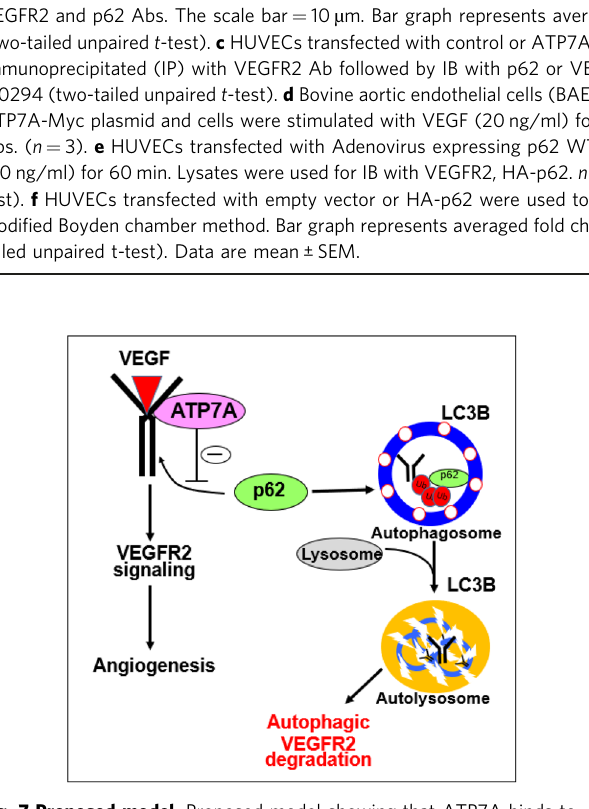
Fig. 6 ATP7A protects against VEGFR2 degradation by preventing VEGFR2 ubiquitination and its binding with p62. a Human umbilical vein endothelial cells (HUVECs) transfected with control or ATP7A siRNAs were stimulated with vascular endothelial growth factor (VEGF) (20 ng/ml) for 30 min in the presence of N-ethylmaleimide (5 mM). Lysates were IP with VEGFR2 followed by immunoblotting (IB) with anti Ubiquitin antibody (Ab) to detect VEGFR2 ubiquitination. The bar graph represents averaged fold change over the control. n = 3, ** p = 0.0031, # p = 0.0002, ** p = 0.0023 (two-tailed unpaired t - test). b HUVECs transfected with ATP7A or control siRNAs were stimulated with VEGF (20 ng/ml) for 30 min and analyzed by immuno fl uorescence using VEGFR2 and p62 Abs. The scale bar = 10 µ m. Bar graph represents averaged number of VEGFR2 and p62 colocalized dots per cell. n = 5, # p = 0.0007 (two-tailed unpaired t -test). c HUVECs transfected with control or ATP7A siRNAs were stimulated with VEGF (20 ng/ml) for 15 and 30 min. Lysates were